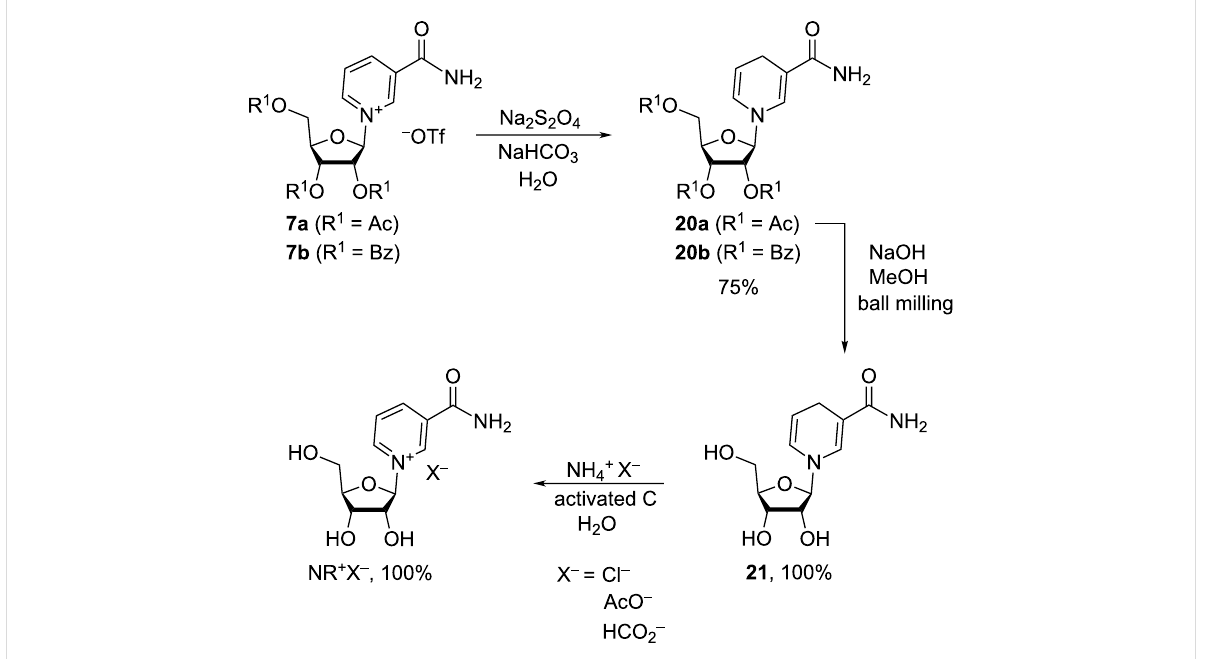
the presence of hydrogen peroxide followed by removal of the cobalt cations with QuadraSil AP resin [60]. The nature of the counter anion vary as a function of the conditions applied.